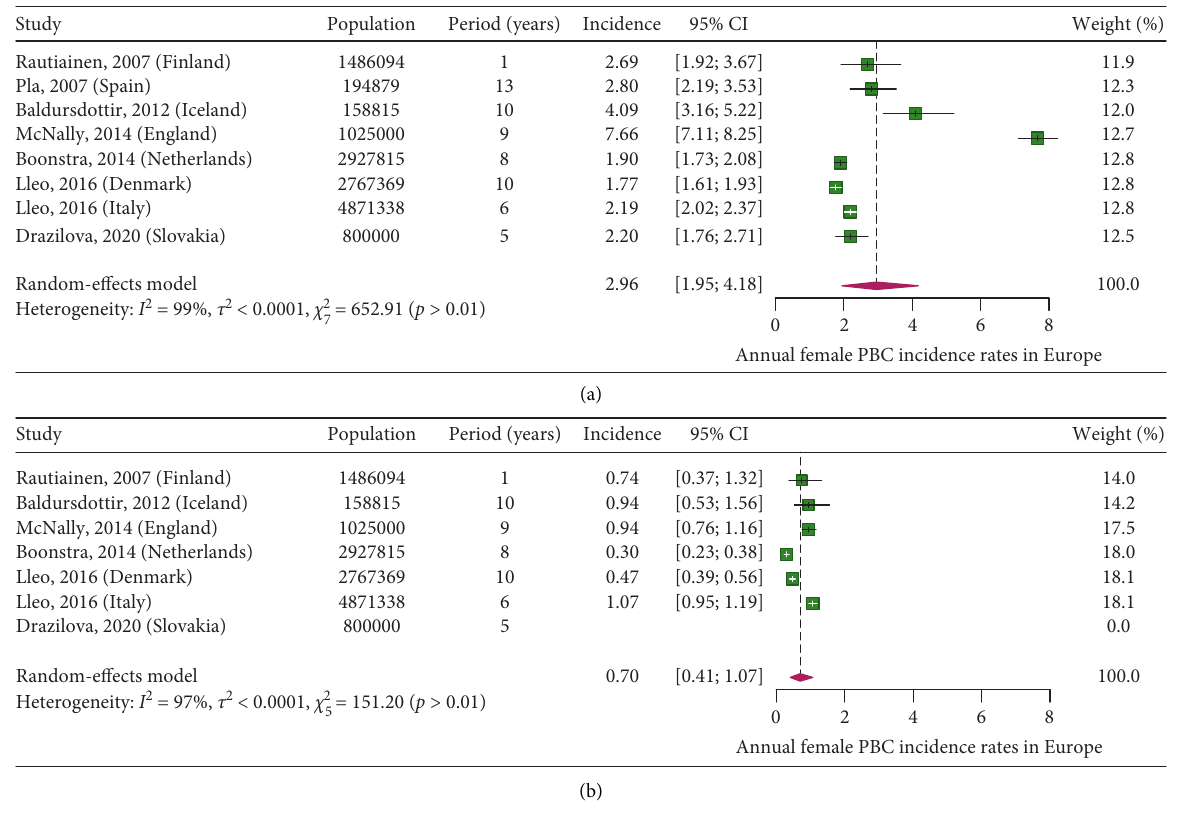
Figure 11: (a) Annual female PBC incidence rates in Europe. (b) Annual male PBC incidence rates in